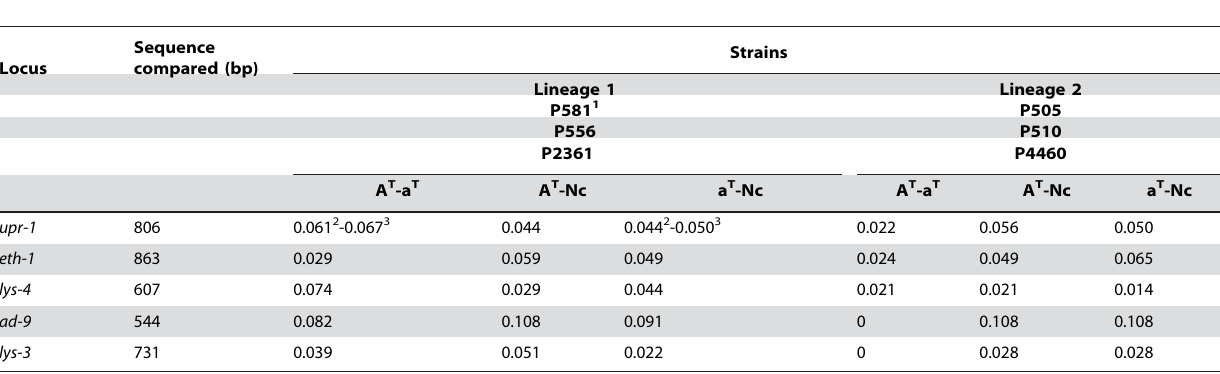
Table 3. Synonymous Sequence Divergence ( d S ) between Alleles of Five Genes on the Mating-Type Chromosome in Two Lineages of N. tetrasperma